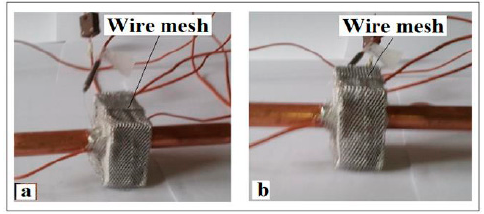
Figure 13. Setting up wire fin for heat transfer experiment.